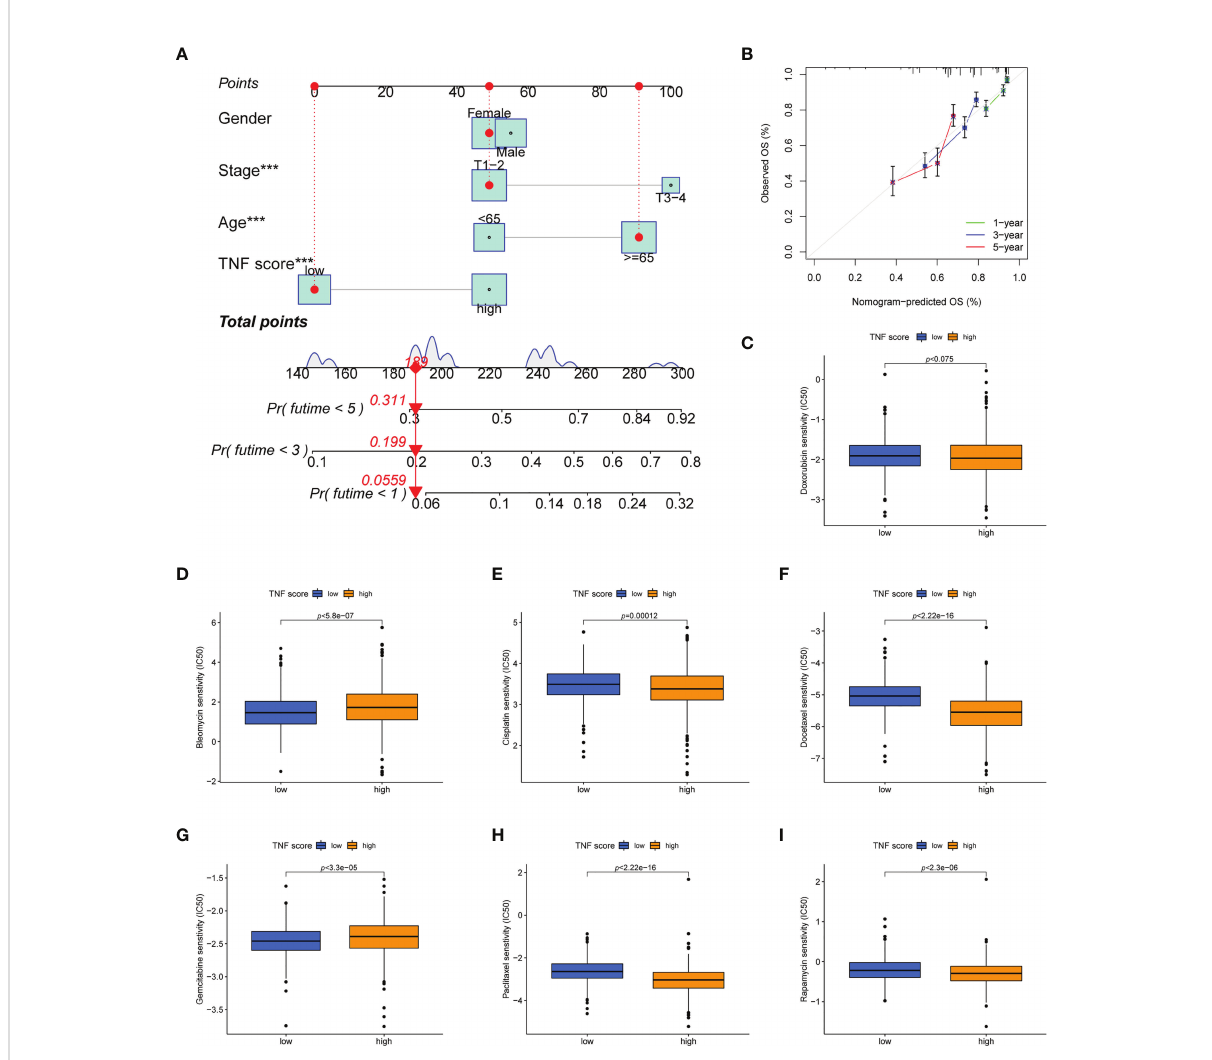
FIGURE 7 Establishment and con fi rmation of a nomogram. (A) Nomogram for predicting the 1-, 3-, and 5-year OS of patients with LUAD in the training set. (B) Calibration curves of the nomogram for predicting 1-, 3-, and 5-year OS in the training set. (C – I) Boxplots show the differences in the estimated IC 50 levels of (C) doxorubicin, (D) bleomycin, (E) cisplatin, (F) docetaxel, (G) gemcitabine, (H) paclitaxel, and (I) rapamycin between TNF score and chemotherapeutic sensitivity; ***p <